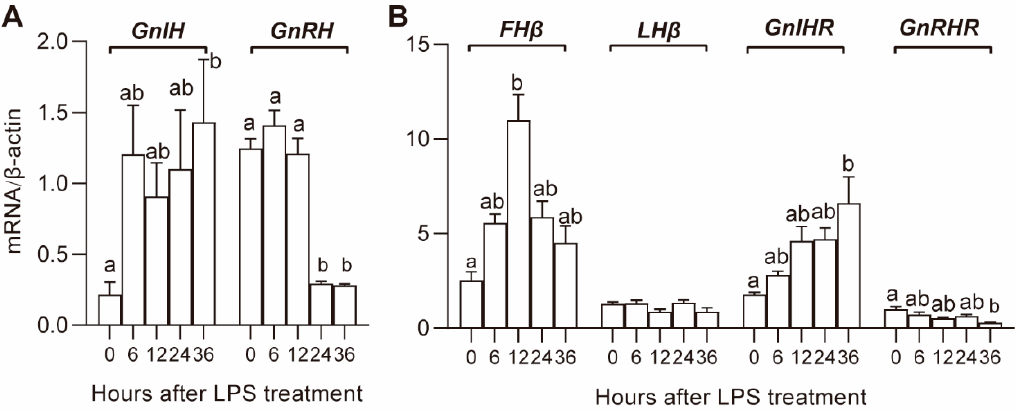
Figure 2. Effect of LPS on gene expression in the hypothalamus ( A ) and pituitary ( B ). Values with different letters are significantly different ( p < 0.05).